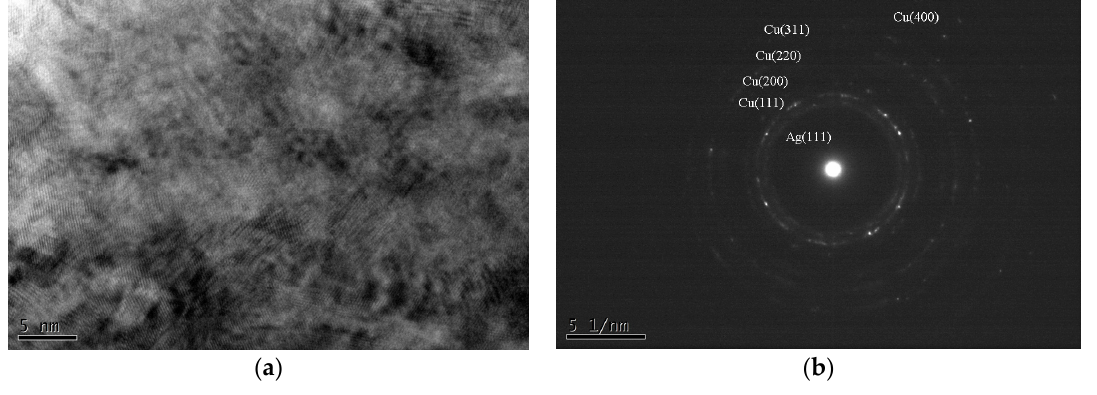
Figure 2. ( a ) Cross-sectional TEM micrograph of a Cu 90 Ag 10 film; ( b ) its diffraction pattern. The circled areas in (a) represent Cu (111).